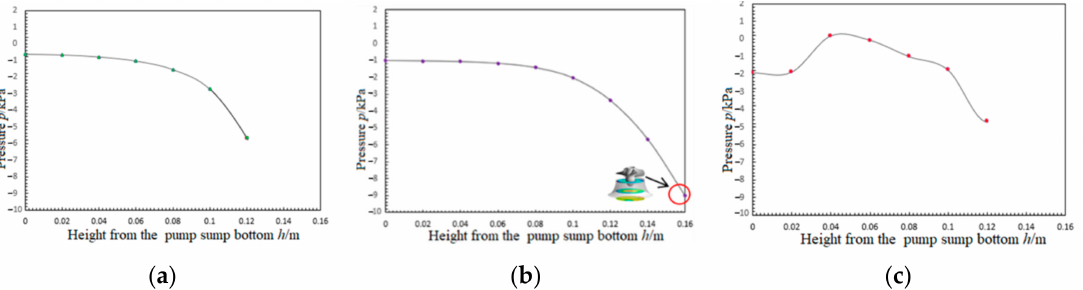
Figure 11. Spatial variation curve of pressure in the vortex center at different moments. ( a ) t = 1.33 s, ( b ) t = 1.63 s, and ( c ) t = 2.23